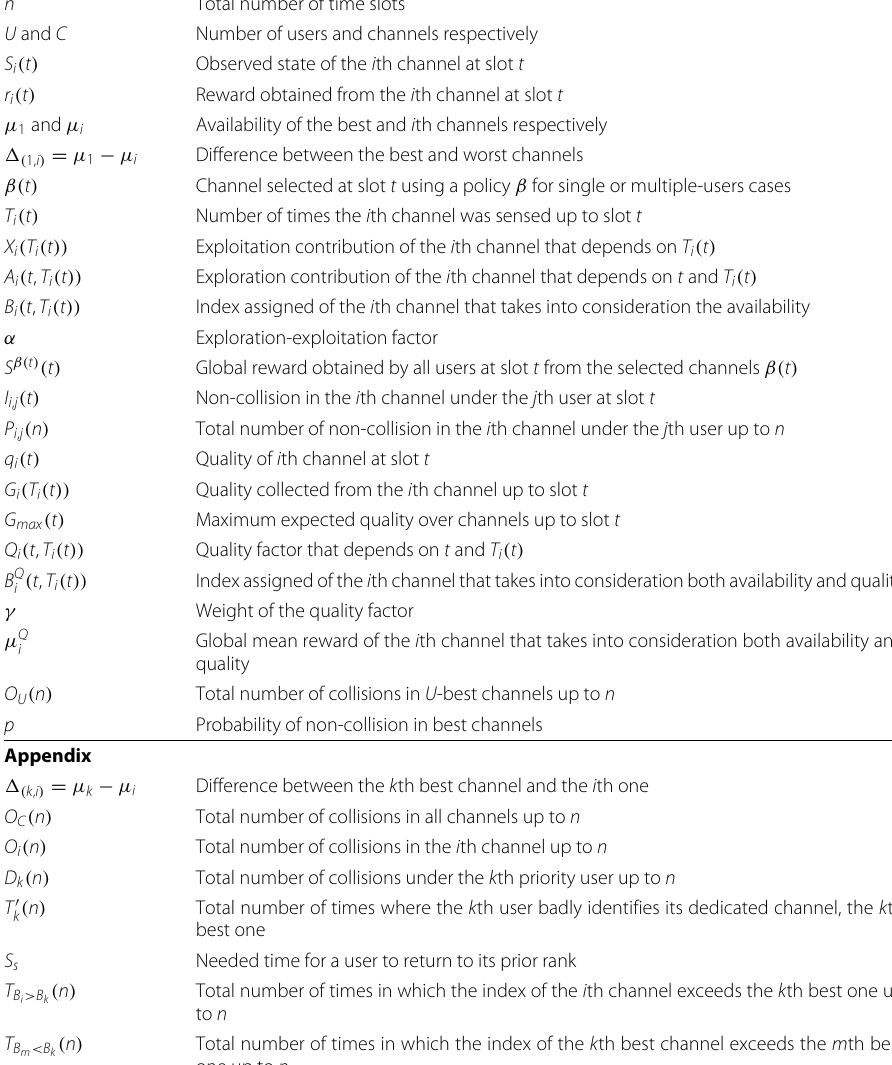
Table 1 List of notations used through the paper